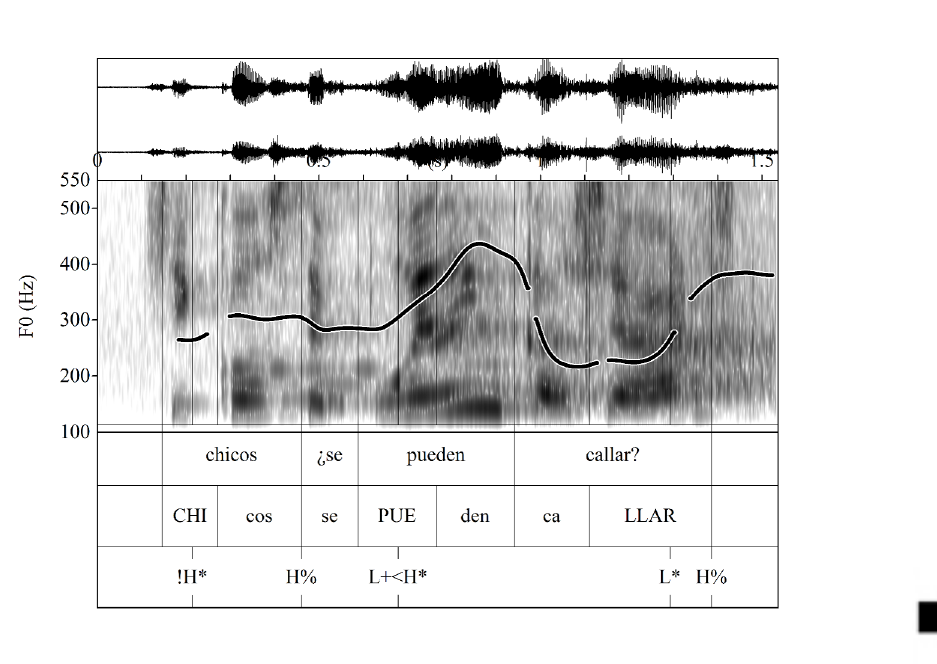
Figure 29 (Participant 12) : Waveform and F0 trace for the vocative within the imperative yes-no question ¿ Chicos, se pueden callar? ‘Kids, can you please be quiet?’ produced as one IP realized as !H* (nuclear position) and H% (boundary tone).